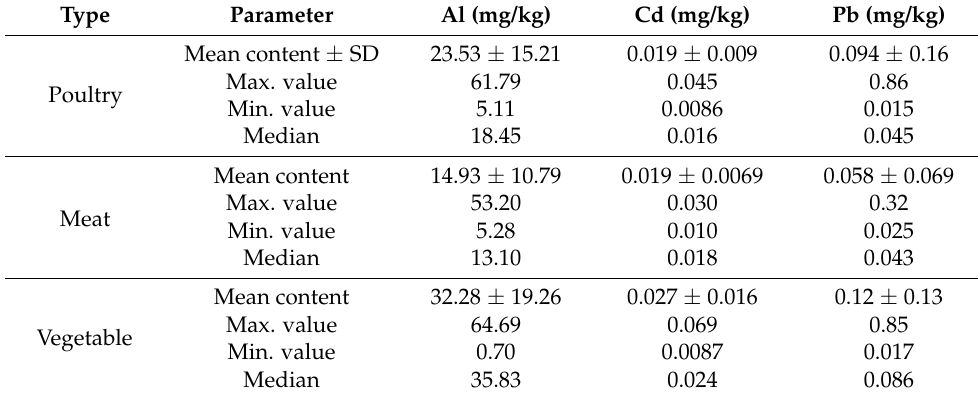
Table 3. Toxic metal levels by soup type.